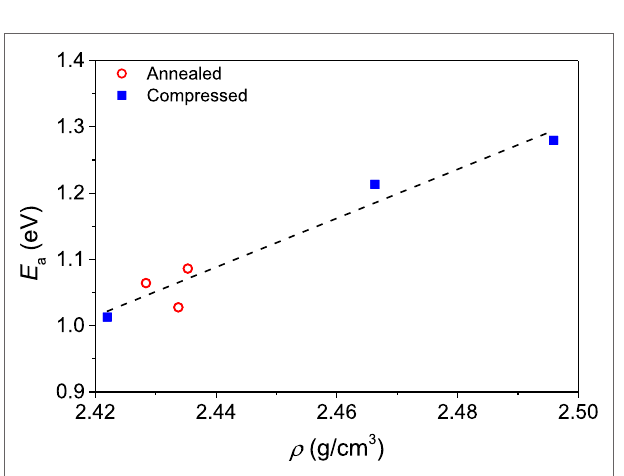
FigUre 8 | compressive stress (cs) as a function of depth of layer (DOl) for glasses compressed or annealed and then ion exchanged at three different temperatures (370, 410, and 450°c) . Arrows denote directions of increasing applied isostatic pressure ( P ) and increasing fictive temperature ( T f ) due to compression and sub- T g annealing, respectively. The dashed orange line is a guide for the eye, showing the relation between CS and DOL for the as-prepared glasses. The orange circle encloses compressed samples ion exchanged at 450°C, as these data do not align with the trend of the other compressed